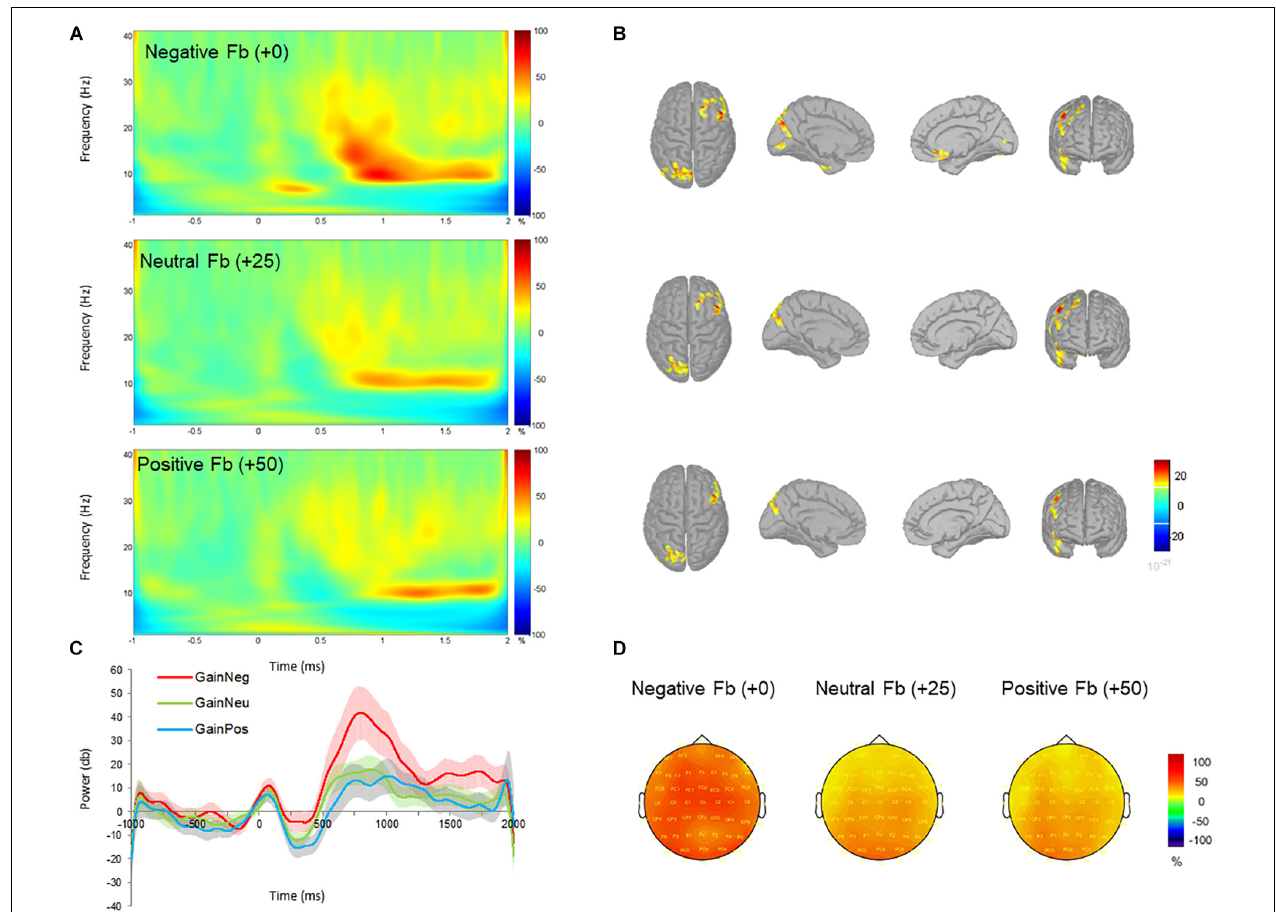
FIGURE 3 | Time-frequency power (total) across negative (+0 MU), neutral (+25 MU) and positive (+50 MU) feedback for gain blocks. (A) Time-frequency plots at channel FCz displaying the changes in power from 700 to 1000 ms with respect to the pre-stimulus baseline (–200 to 0 ms). (B) Beta (12–20 Hz) source activity corresponding to each feedback type displayed for top, left medial, right medial and frontal views. Source activation maps are based on a minimum of 30 vertices with an amplitude threshold value is set to 30%. (C) Time-course of mean beta power with standard error bars in negative (red), neutral (green), and positive (blue) feedback conditions. (D) Scalp topographies plotted at 800 ms post-feedback for 15